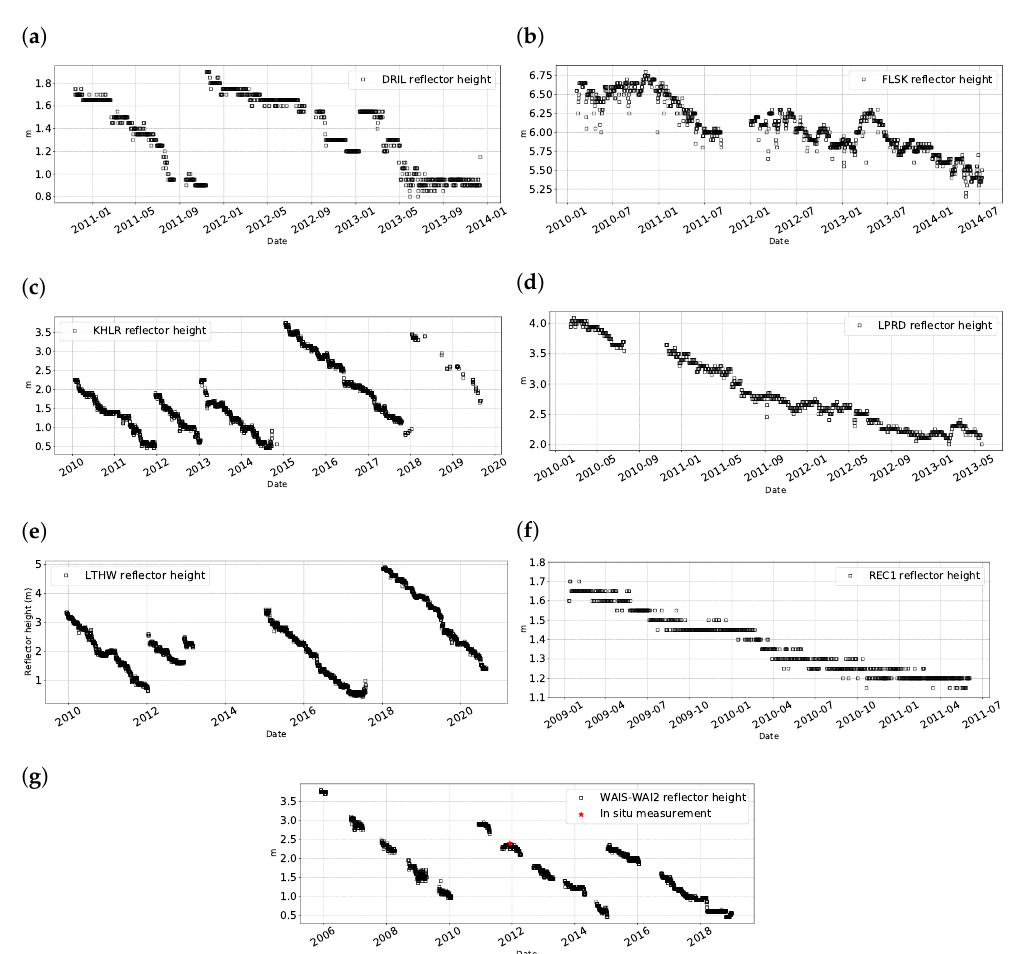
Figure 9. Reflector height time series for the eight POLENET (Polar Earth Observing Network) antennas considered in this analysis: ( a ) DRIL, ( b ) FLSK, ( c ) KHLR, ( d ) LPRD, ( e ) LTHW, ( f ) REC1, and ( g )